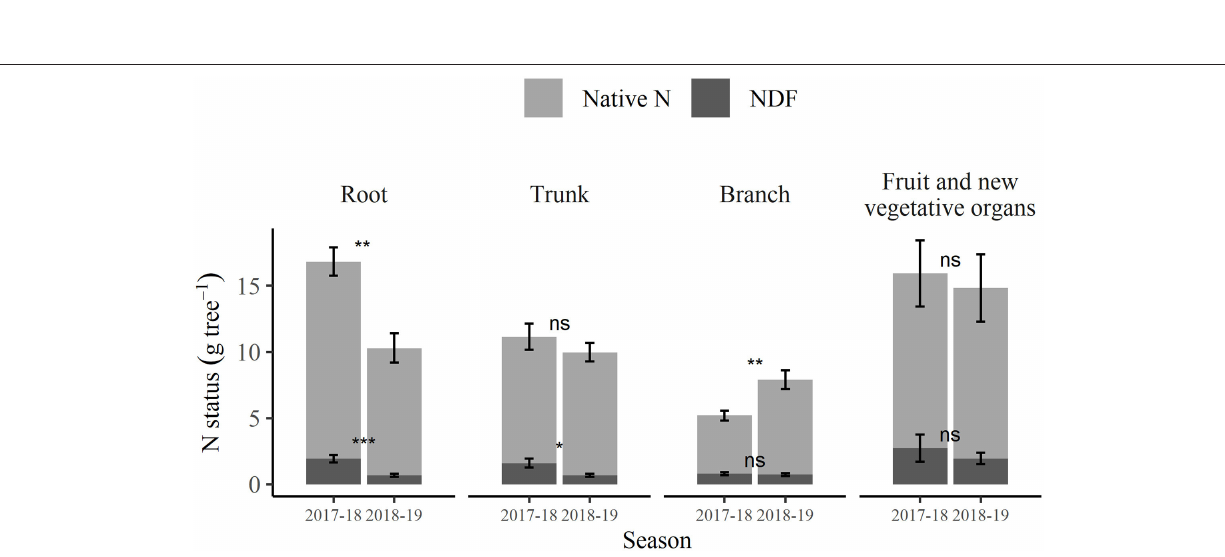
FIGURE 7 | Total N contained in the roots, trunk, branches, and seasonal canopy showing the composition of N derived from native N and nitrogen derived from fertilizer (NDF) at winter dormancy of 2017–2018 season and at 1 week after fruit harvest timing of the 2018–2019 season (March 2019). Error bars represent ± SEM, n = 12. For each organ, notation indicating the extent of difference related to the time of sampling from unpaired two-sample t -test: ns p > 0.05; * p < 0.05; ** p < 0.01; *** p <